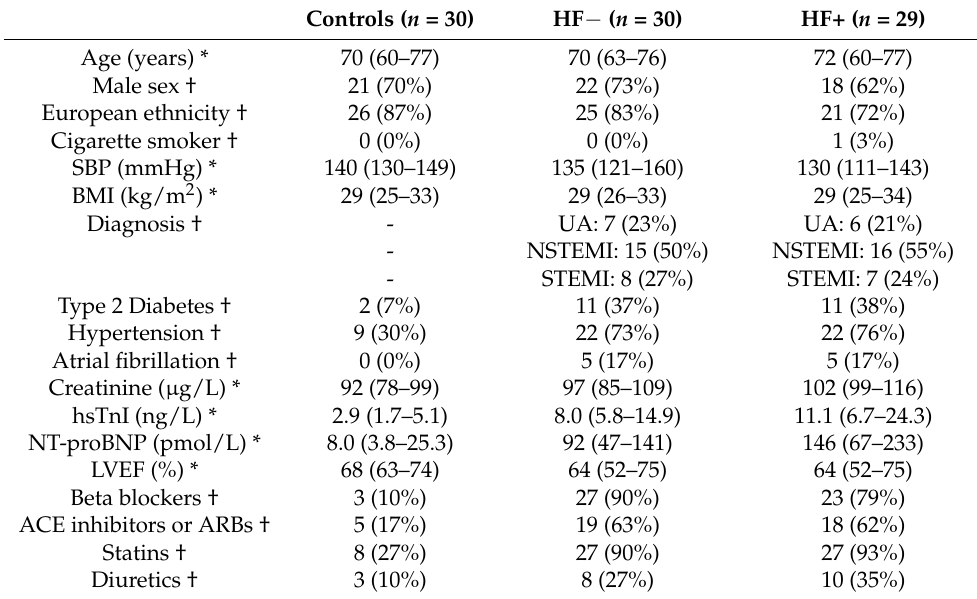
Table 2. Clinical characteristics of patients and